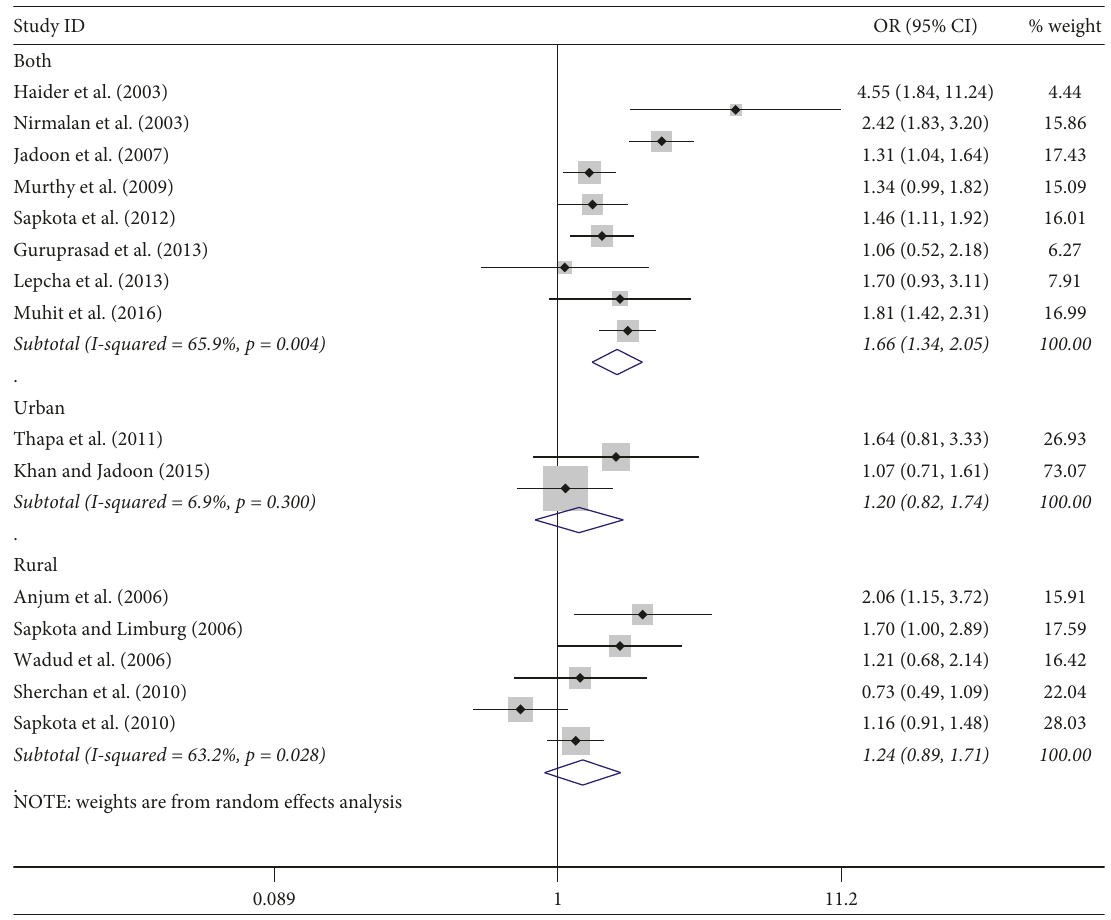
Figure 9: Subgroup analysis of CSC by location on a person basis at visual < 3/60 level. CSC � cataract surgical coverage; OR � odds ratio; CI � confidence